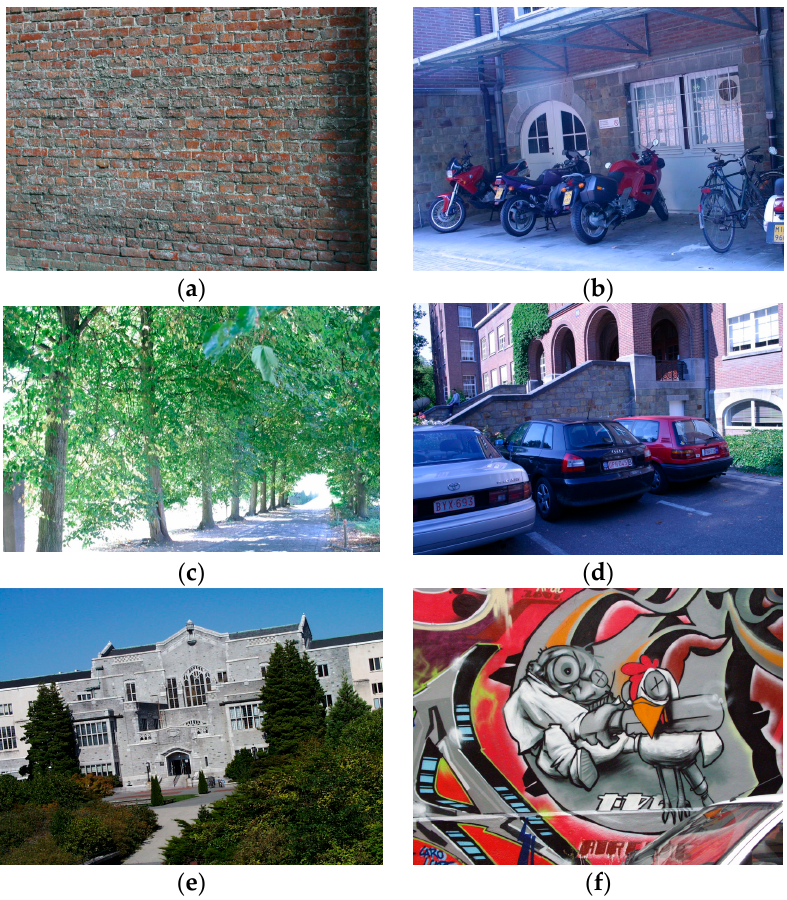
Figure 3. Image sequences from the Affine Covariant Features dataset. ( a ) wall; ( b ) bikes; ( c ) trees; ( d ) leuven; ( e ) UBC; ( f ) graffiti.